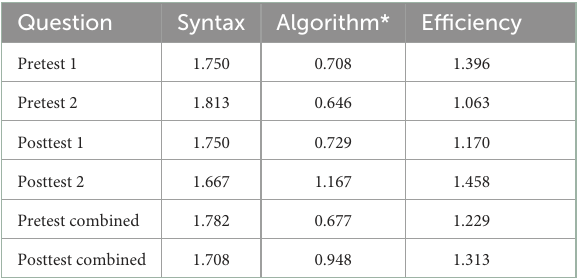
TABLE 3 Post-survey open ended questions and selected responses. Question Responses